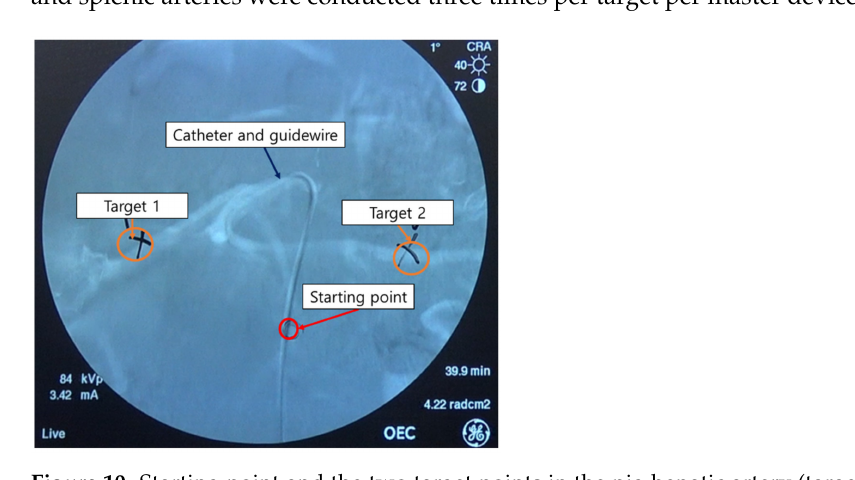
Figure 10. Starting point and the two target points in the pig hepatic artery (target 1) and splenic artery (target